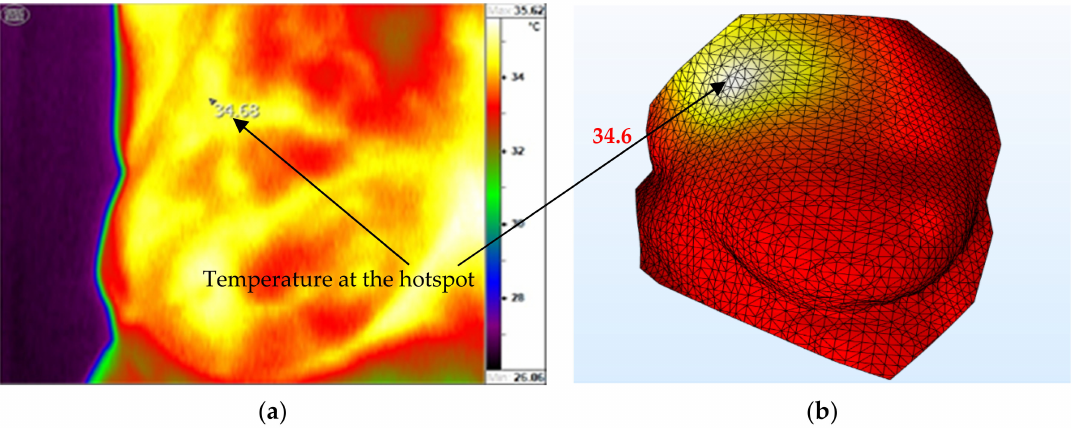
Figure 10. Comparison of measured ( a ) and computed ( b ) temperature distributions (patient No. 1) with a percentage error of 0.23% in hotspot temperature prediction.